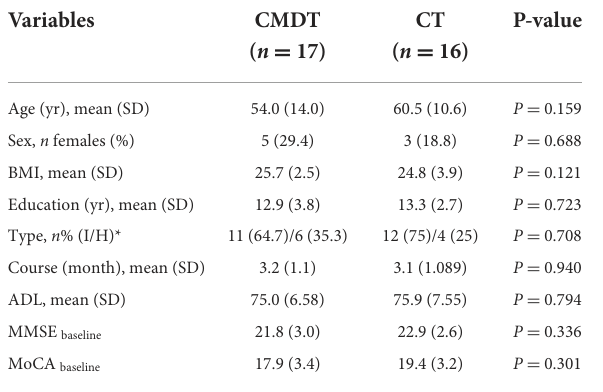
FIGURE3 Training effect on the primary outcome measurement.